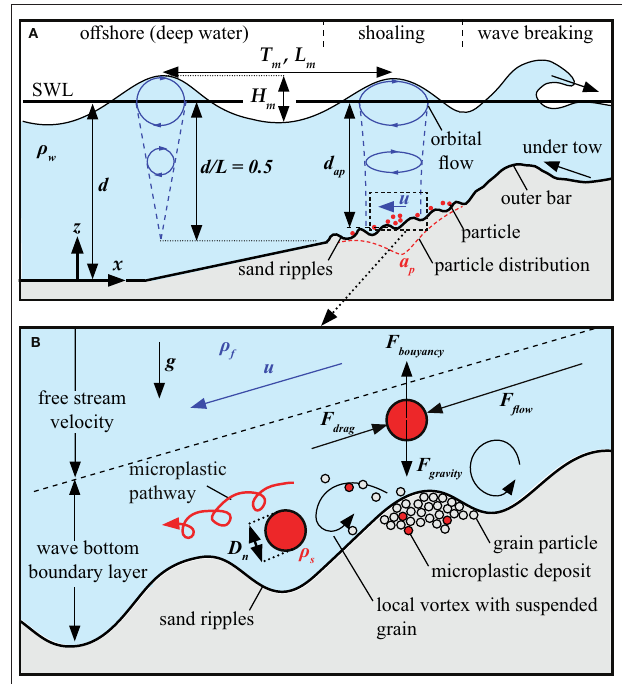
FIGURE 1 | (A) Parameter definition and two-dimensional flow conditions in the wave shoaling zone [inspired by Greenwood (2003)]. (B) Force balance of MP particles, near-bottom boundary layer, and flow-induced vortex systems at ripples below a wave